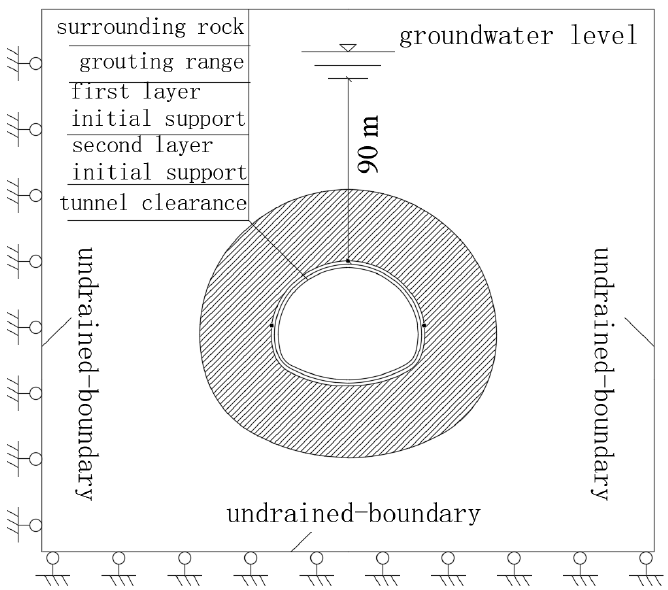
Figure 4. Sketch map of radial grouting model.